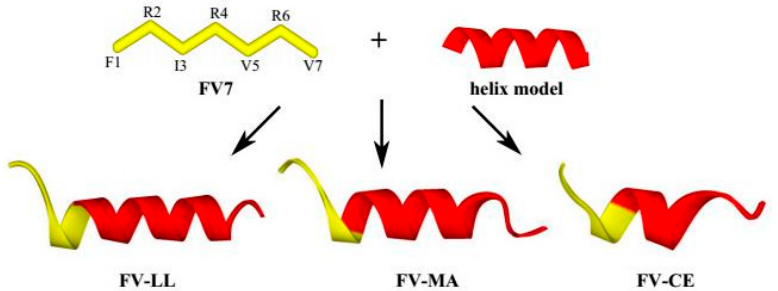
Figure 1. Three-dimensional structure projections of peptides and the process of hybrid peptide formation. FV7 is yellow, the helix model of the core sequences from native peptide (LL37, magainin 2 and cecropin A) is red.